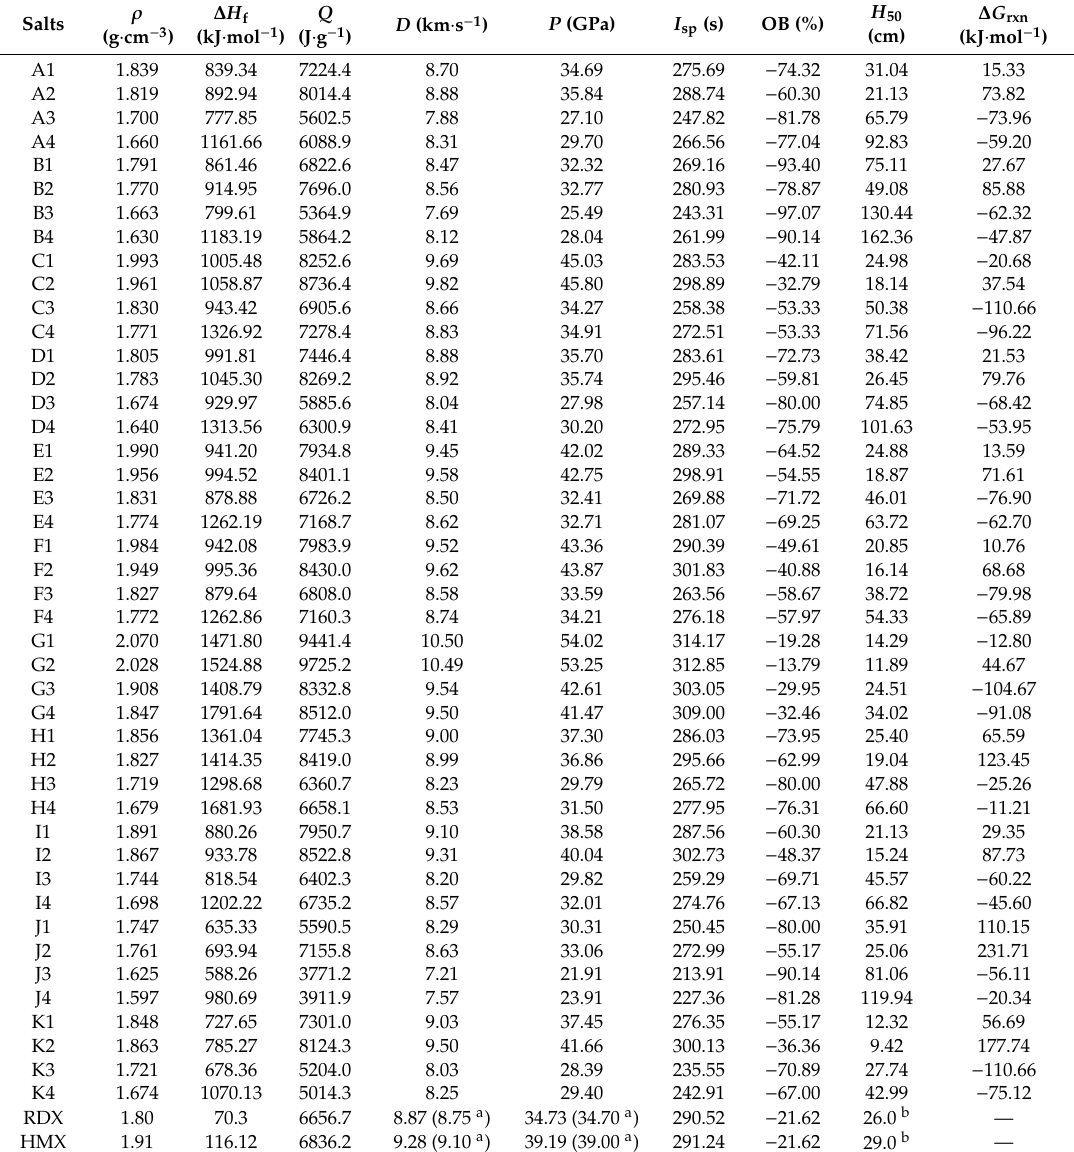
Table 1. Predicted densities ( ρ ), heats of formation ( ∆ H f ), heats of detonation ( Q ), detonation velocities ( D ), detonation pressures ( P ), oxygen balance (OB), impact sensitivity ( H 50 ) and Gibbs free energies